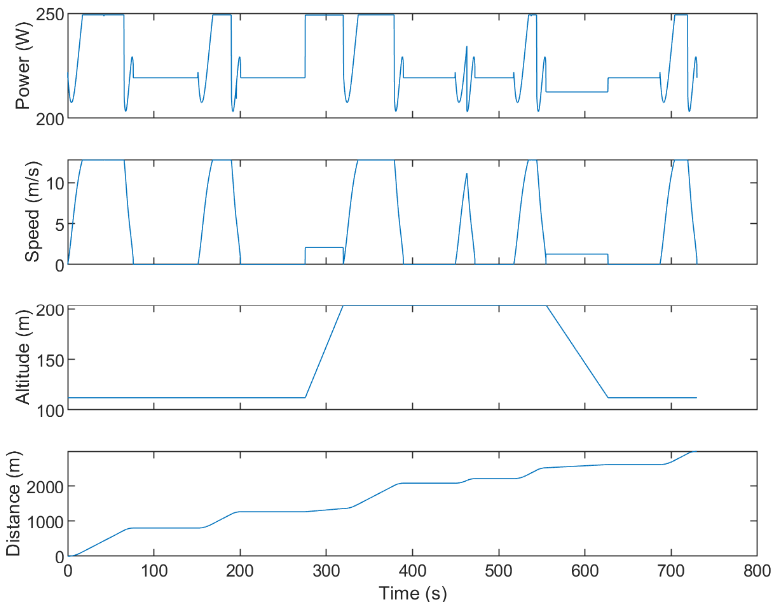
Figure 10. Same paths as in Figure 9, but shown in 3D.